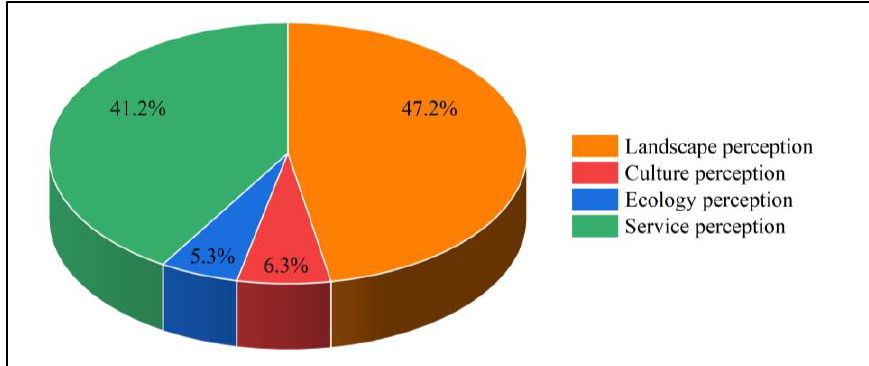
Figure 2. Distribution of degree of different perception types.